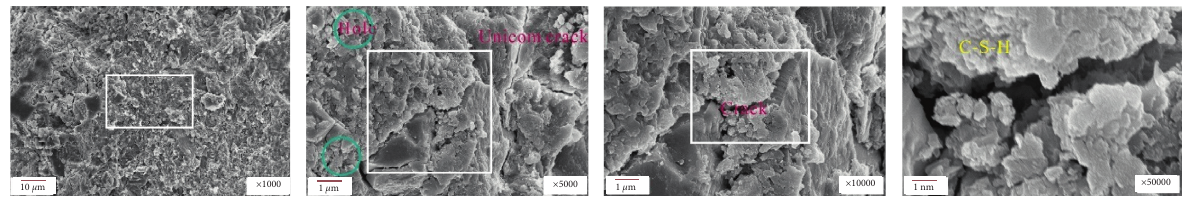
Figure 20: C-0 concrete microstructure after 400 freeze-thaw cycles.